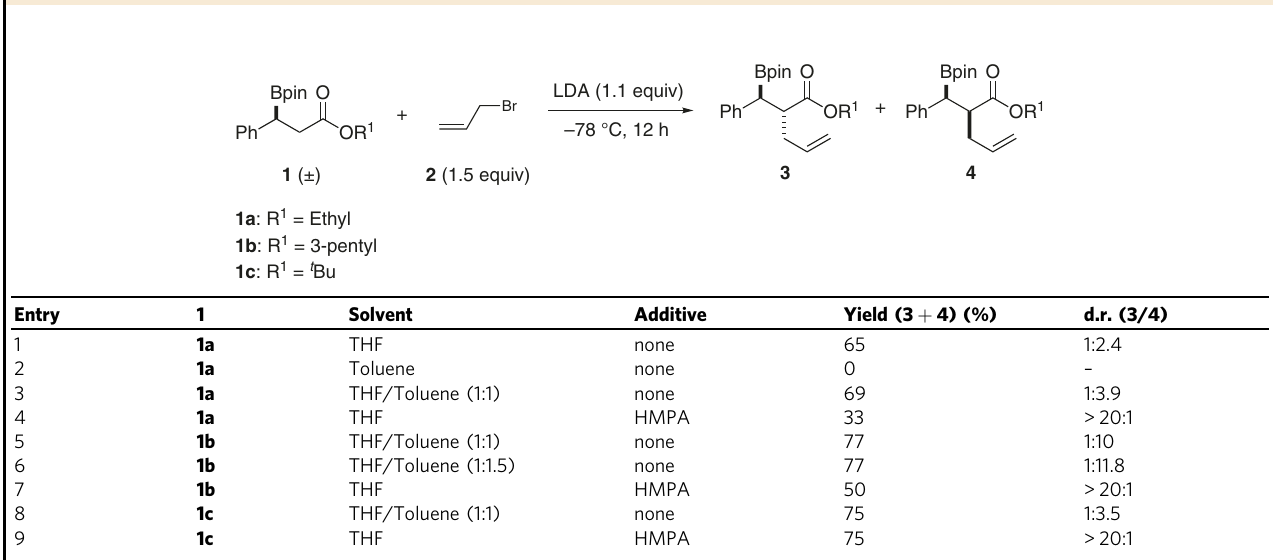
Table 1 Condition optimization for the allylation of β - boronyl esters a